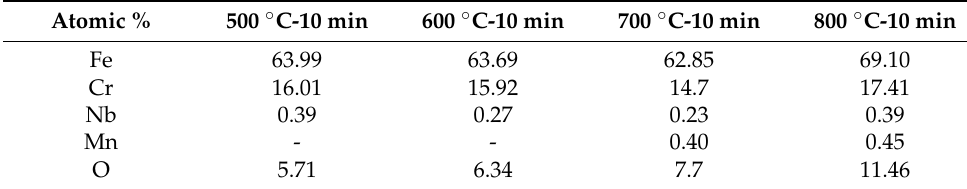
Figure 1. Surface morphology after treatment at 500, 600, 700, and 800 ◦ C for 10 min (scale bar: 1 µ m). Table 2. Elemental composition determined through